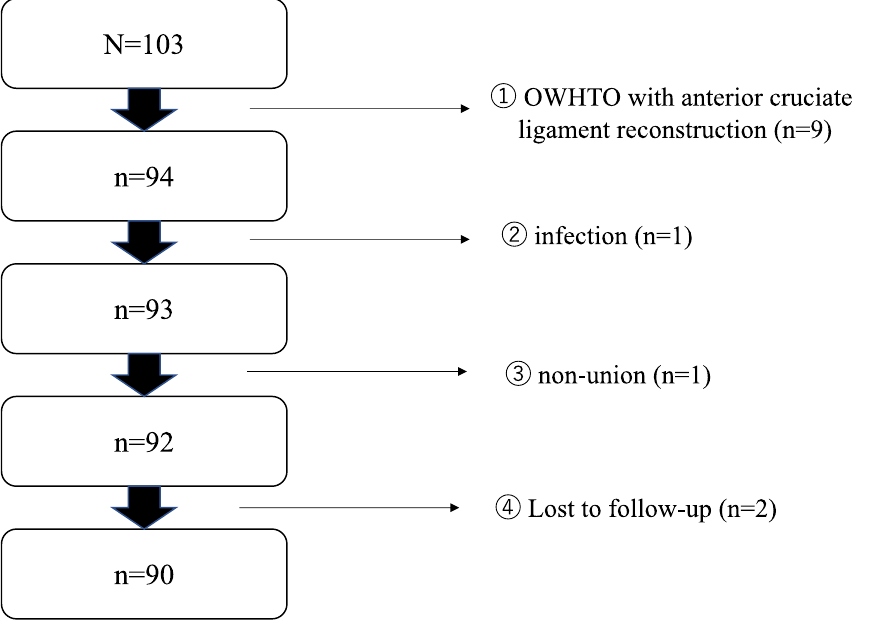
Figure 3. Flowchart of patient